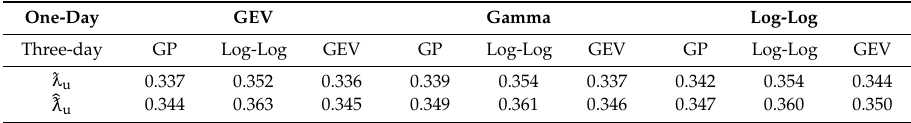
Figure 2. Scatter plots of the one ‐ day and multi ‐ day rainfall with marginal histograms. ( a ) one ‐ day and three ‐ day rainfall ( b ) one ‐ day and seven ‐ day rainfall.